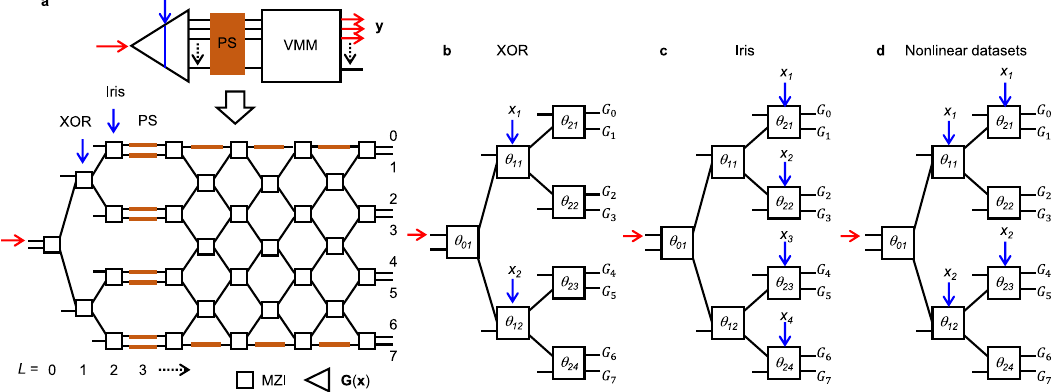
Fig. 1 Schematics of the projection-based photonic classi fi er. a Topology to be fabricated for experimental demonstration. A schematic to present the device topology is depicted at the top. The layer L is numbered for each column of MZI (Mach – Zehnder interferometer) or phase shifters (PS) (in total 11 layers). Data-input schemes for constructing mapping functions G ( x ) = { G 0 , G 1 , … , G 7 } by arranging the data input into the MZI-based photonic network: b XOR (exclusive OR); c Iris; d Nonlinear datasets, in which each MZI has a phase bias θ jk ( j : the column number, k : the row number) as its learning parameter. The topology in ( a ) can accommodate the schemes in ( b – d ) by using the layer L = 1 or 2 and both for data input. VMM (vector-matrix multiplication) has a 7-layer MZI mesh (column× row = 4 × 4 + 3 × 3). All MZIs use 50:50 splitters. XOR and the nonlinear datasets have two parameters x = ( x 1 , x 2 ) ( x i = 0 or 1 for XOR, x i ∈ [0,1) for nonlinear datasets), while the Iris dataset has four parameters x = ( x 1 , x 2 , x 3 , x 4 ). Red arrows indicate the light input and output. Blue arrows indicate the data input from electrical domain. Yellow color denotes the phase